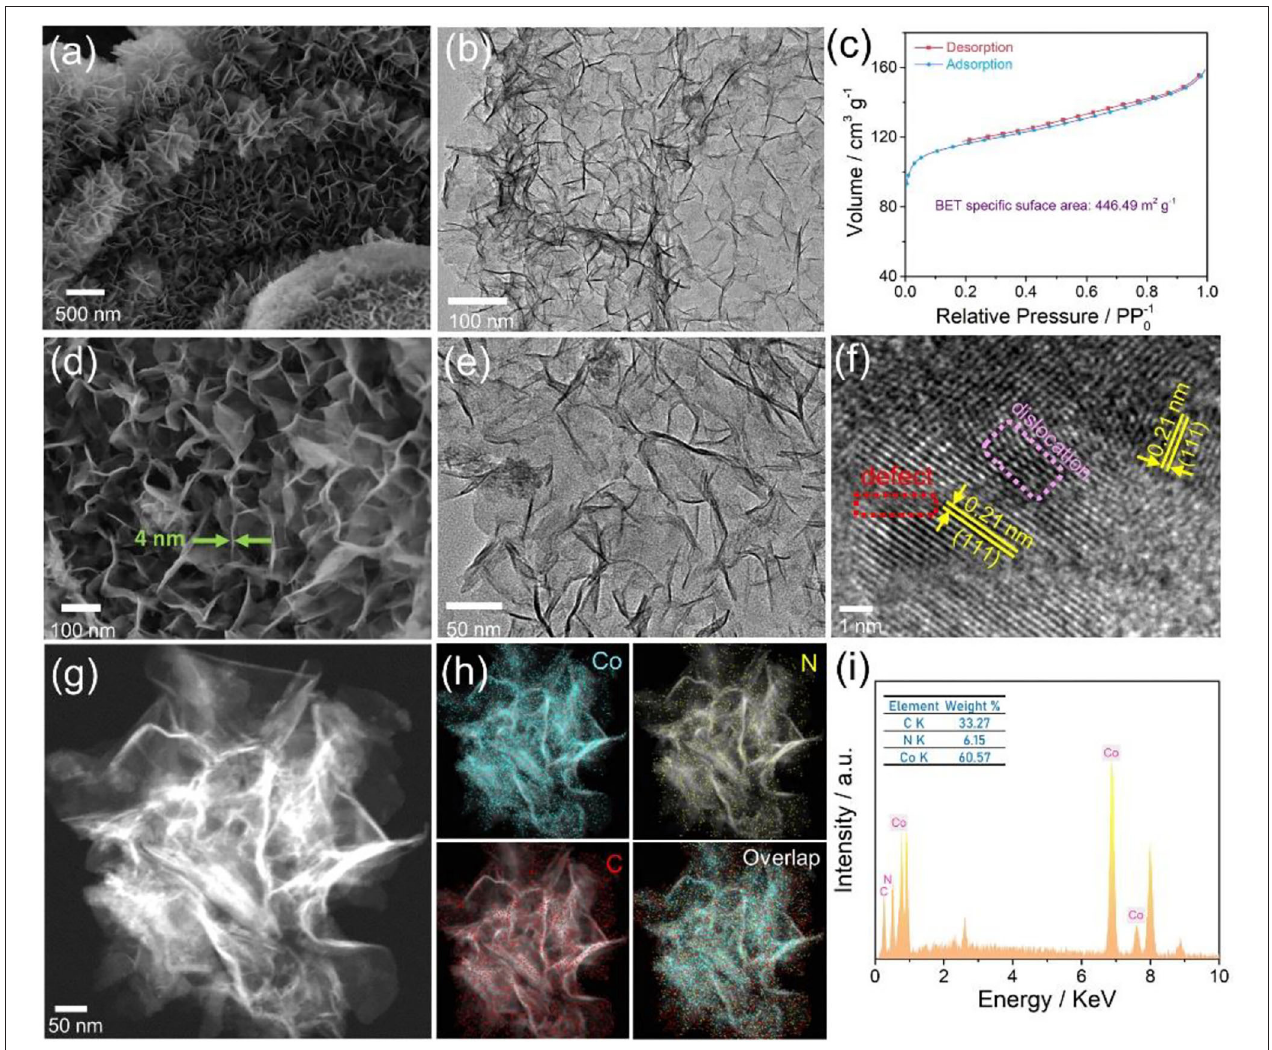
FIGURE 2 | Morphology characterization of the composite Co-NS@NCP: Large-area (a) SEM and (b) TEM images; (c) N 2 adsorption-desorption isotherms; (d) Magnified SEM and (e) TEM images; (f) HRTEM image; (g) HAADF-STEM image and (h) corresponding EDX element mapping images; (i) EDX